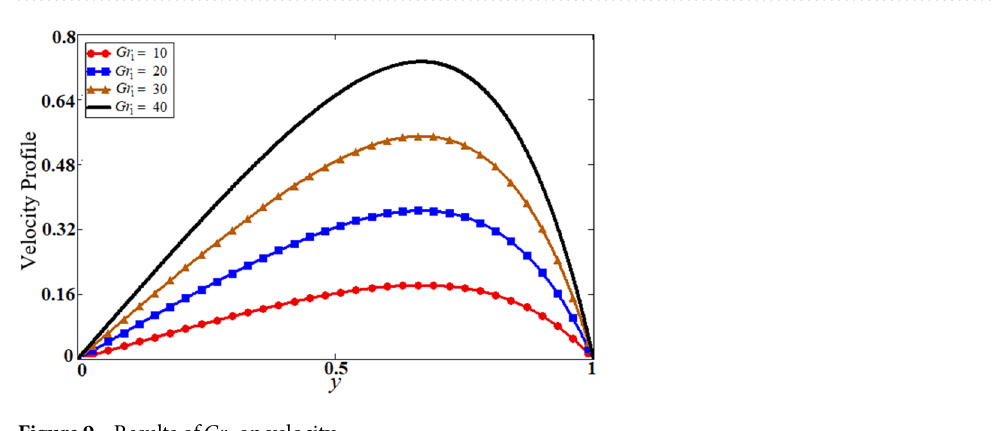
Figure 9. Results of Gr 1 on